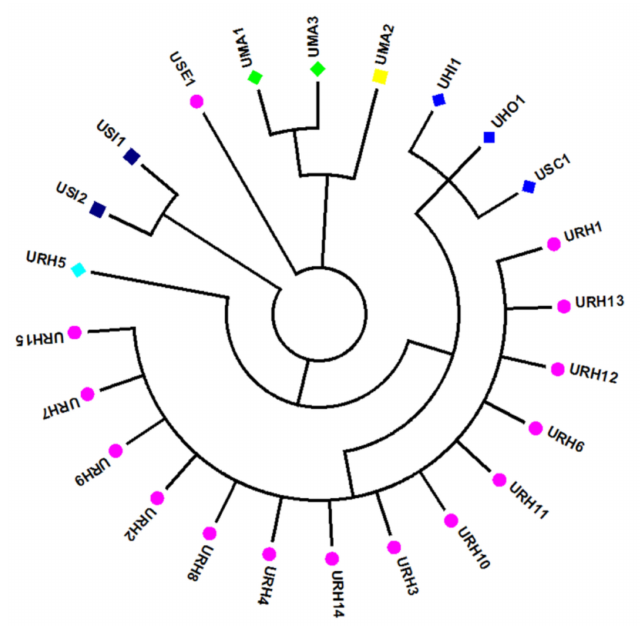
Figure 1. Results of NJ-tree analysis based on ITS sequences of the 24 Uncaria